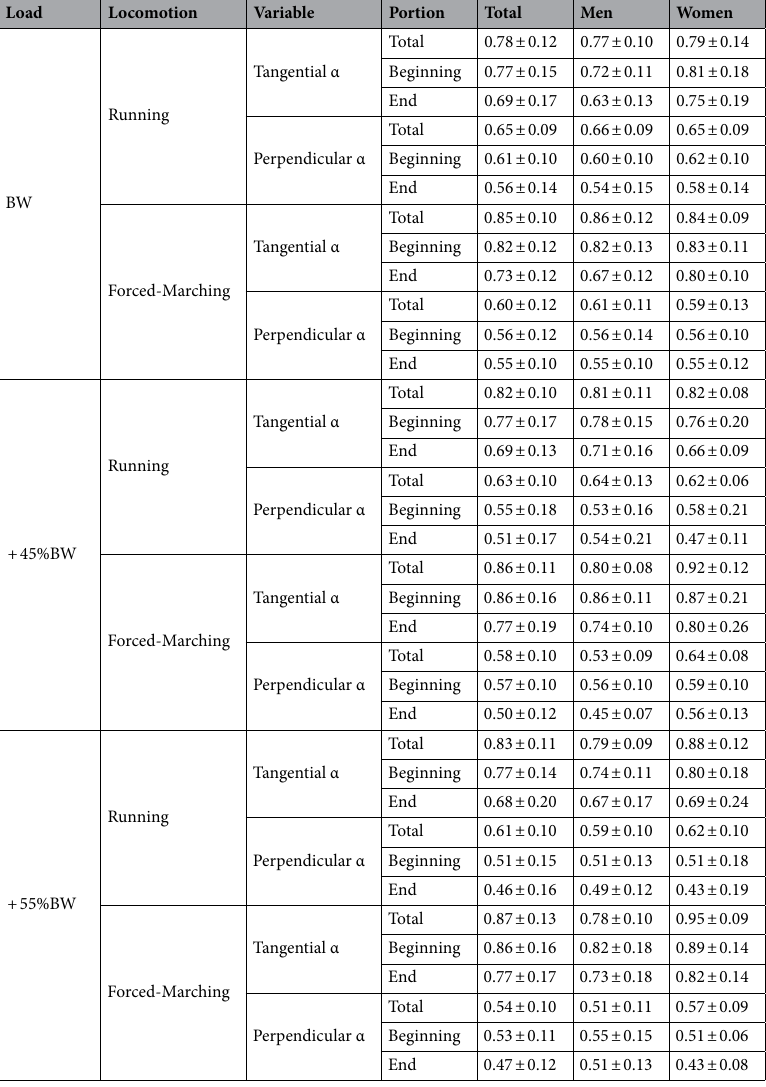
Table 5. Stride-to-stride regulation. mean ± standard deviation. α = alpha coefficient derived from detrended fluctuation analysis; BW = Body weight (no load); + 45%BW = An additional 45% of BW; + 55%BW = An additional 55% of BW; Total = Entire trial; Beginning = First 30% of the trial only; End = Last 30% of the trial only; α = 0.5 represents stochastic (random) control; α < 0.5 represents anti-persistent regulation (strict control); α > 0.5 represents persistent behavior (looser/weaker control); α ≥ 1.5 represents over regularity (no